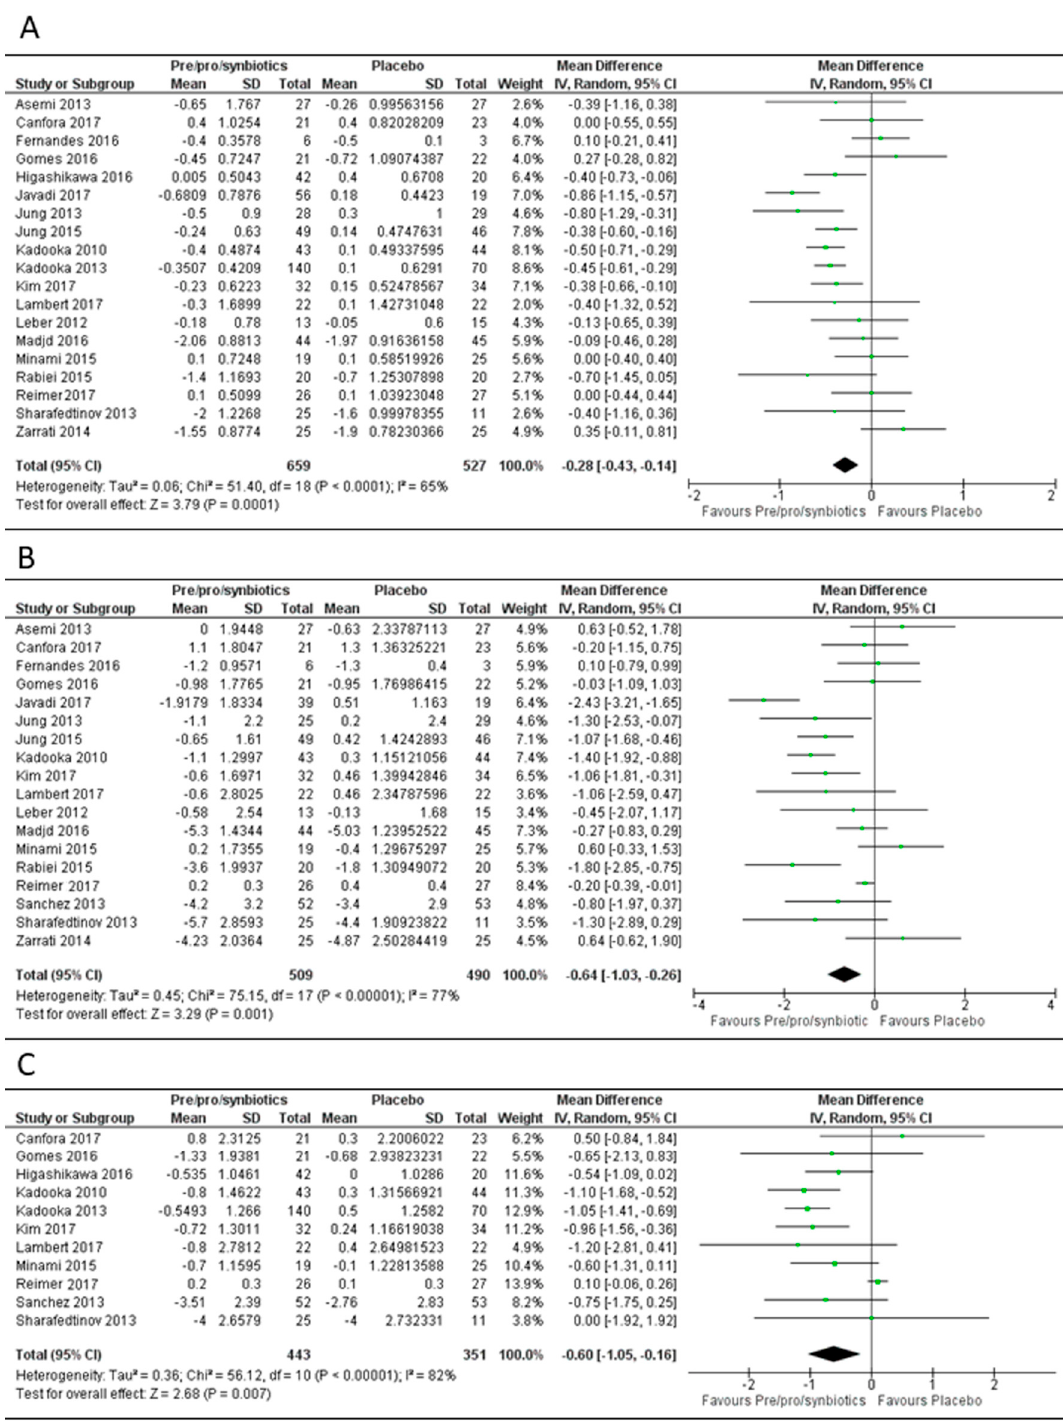
Figure 3. Forest plot of effect of any dietary modulation agent (prebiotic/probiotic/synbiotic) on: ( A ) body mass index (BMI); ( B ) body weight; ( C ) fat mass. Data synthesis using the random effects model for the mean differences amongst the included randomized controlled trials comparing all gut microbiome-modulating interventions (prebiotics/probiotics/synbiotics) vs. placebo showed significant differences for BMI in 19 studies ( A ) (overall mean difference (MD) = − 0.28 (95% CI − 0.43, − 0.14), p < 0.001), body weight reduction in 18 studies ( B ) (MD = − 0.64 kg (95% CI − 1.03, − 0.26), p < 0.001) and fat mass in 11 studies ( C ) (MD = − 0.60 kg (95% CI − 1.05, − 0.16), p < 0.001). CI: Confidence intervals. SD: Standard deviation.